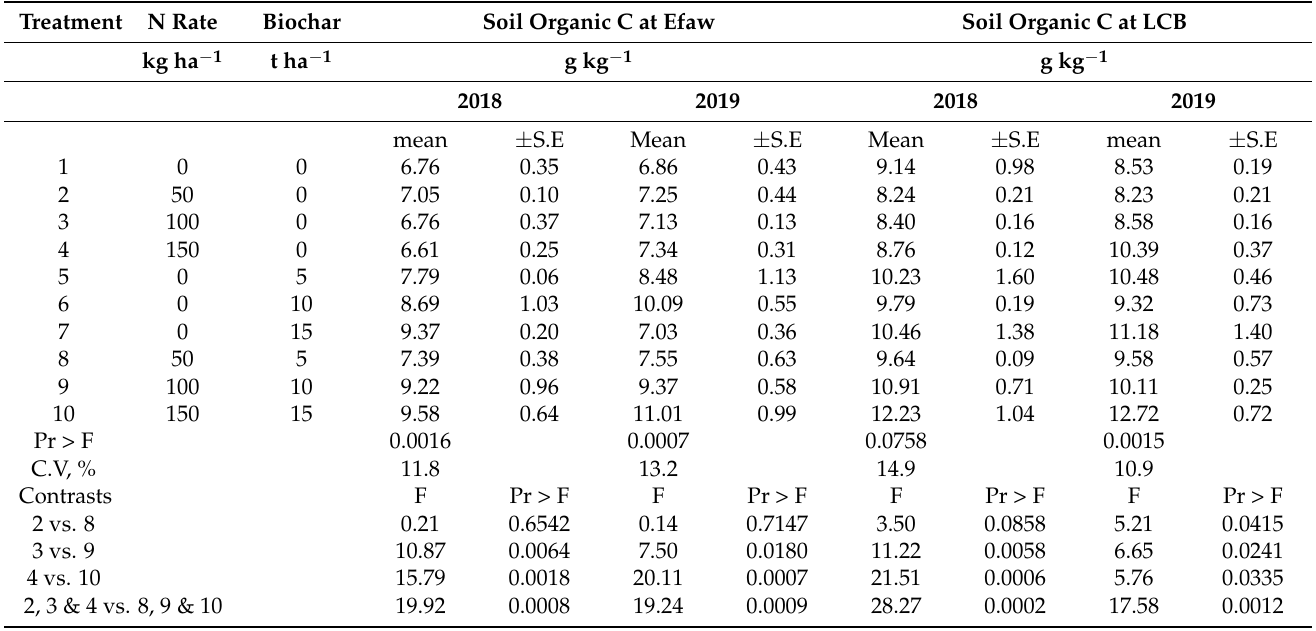
Table 4. Mean soil organic C for treatments plus the associated contrasts between N fertilizer and biochar-N combinations at Efaw and Lake Carl Blackwell, Stillwater, Oklahoma. 2018 and 2019.